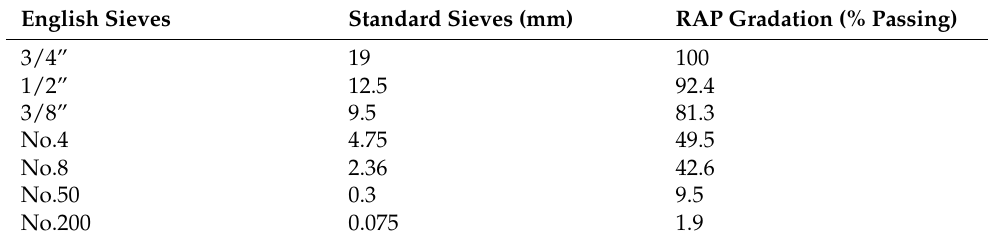
Table 2. RAP’s gradation.